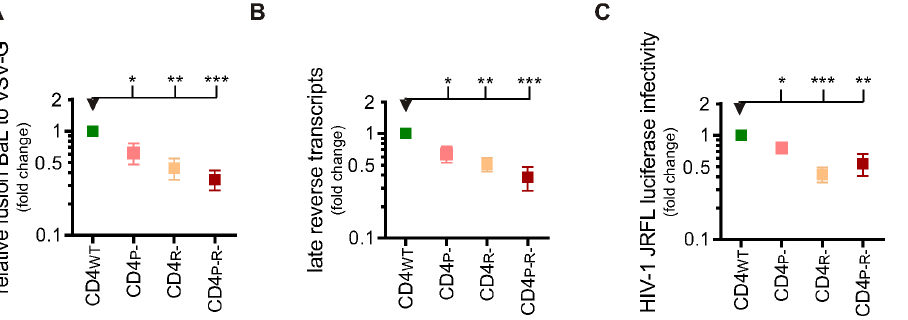
Figure 6. HIV-1 infection is reduced when CD4 is excluded from DRM in macrophages. A) HIV-1 viral fusion in PSC-macrophages. The percentage of fusion of HIV-1 virions was normalised to the percentage fusion of VSV-G pseudotyped virions. Symbols represent the normalised mean fusion relative to the PSC-macrophages CD4 WT group of four independent experiments 6 SEM (n=4). B) Reverse transcription of HIV-1 in PSC- macrophages. Late (pol) products were detected using qPCR after 30 h of infection. Symbols represent the relative mean number of copies of HIV-1 DNA of four independent experiments 6 SEM (n=4), normalised to the number of cells using a b -actin control. C) HIV-1 productive infection in PSC- macrophages. Infection was measured by detecting luciferase activity in PSC-macrophages three days after transduction with NL4.3.Luc.R-E- virus pseudotyped with HIV-1 or VSV-G envelope. HIV-1 NL4.3.Luc.R-E- transduced cells were normalised to VSV-G NL4.3.Luc.R-E- transduced cells.Symbols represent the mean luciferase detection relative to the PSC-macrophages CD4 WT group of six independent experiments, 6 SEM (n=6).